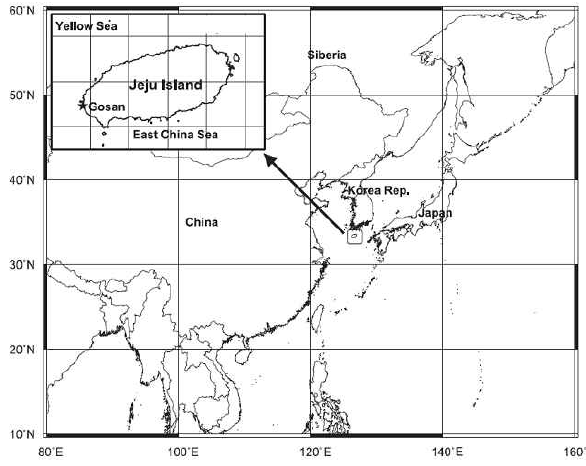
Fig. 1. Image map of Gosan supersite (33.17 ◦ N, 126.10 ◦ E) on